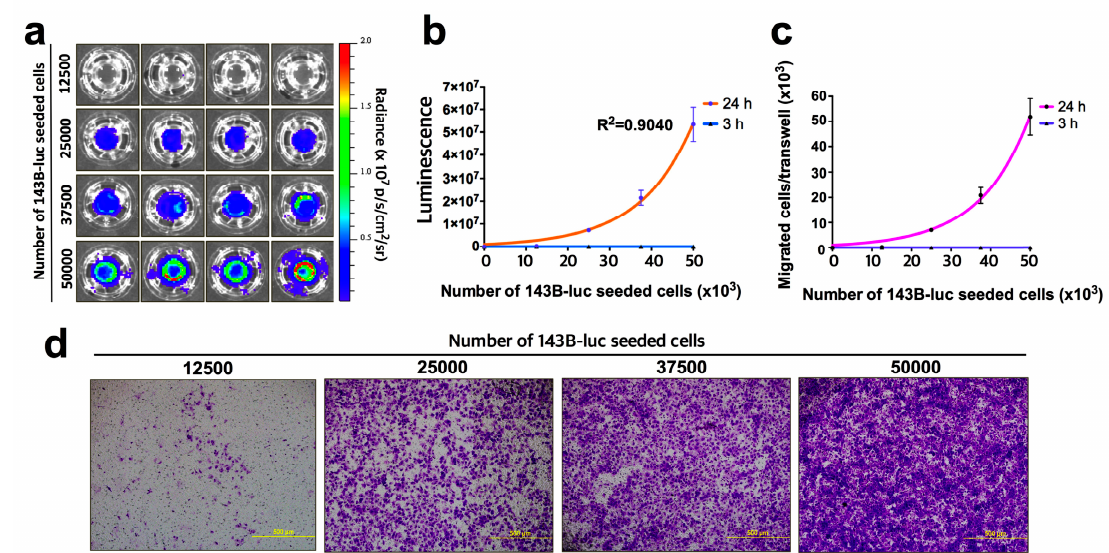
Figure 4. Seeded tumor cell number correlates highly with migrated tumor cell number as measured using bioluminescence imaging. ( a ) 143B-luc osteosarcoma cells were seeded in transwells (n = 4) at the cell densities indicated, incubated for 24 h and then the migrated tumor cells imaged after the addition of D-luciferin using the IVIS ® Spectrum. ( b ) Intensity of the luminescent signal received from transwells versus the number of seeded tumor cells at 3 and 24 h. ( c ) Luminescence data in ( b ) converted to the number of migrated tumor cells per transwell (value for luminescence / cell obtained from standard curve—Figure A2). ( d ) Representative images of crystal violet staining of migrated tumor cells at 24 h at tumor cell seeding densities as indicated (100 × magnification). Bars represent SEM.